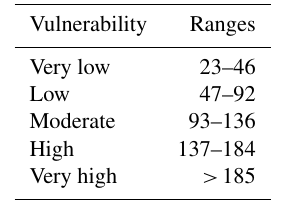
Table 2. Range of vulnerability related to the DRASTIC